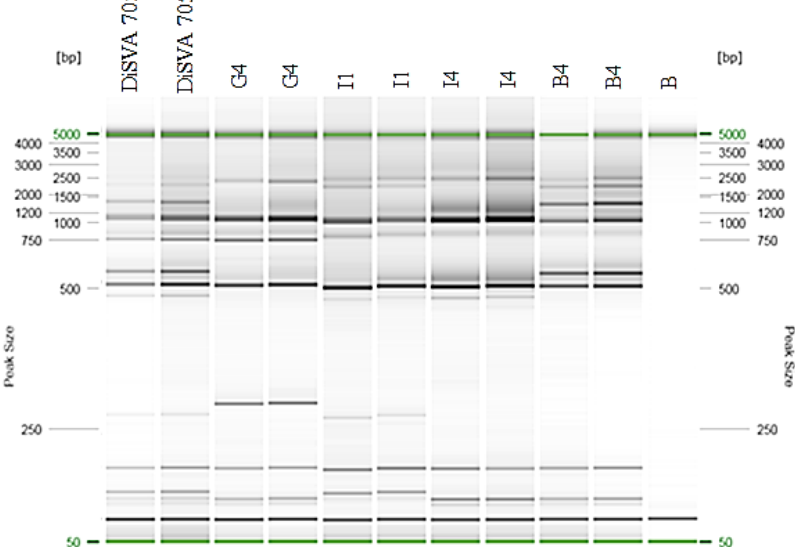
Figure 2. Molecular fingerprinting of the potential improved strains using primer pair δ 12–21. The native DiSVA 705 strain was used as control. Each strain was analyzed in duplicate to confirm. The QX Size Marker 50 bp / 5 kb (Qiagen) was used for fragment size. Lane B was indicated as negative control.